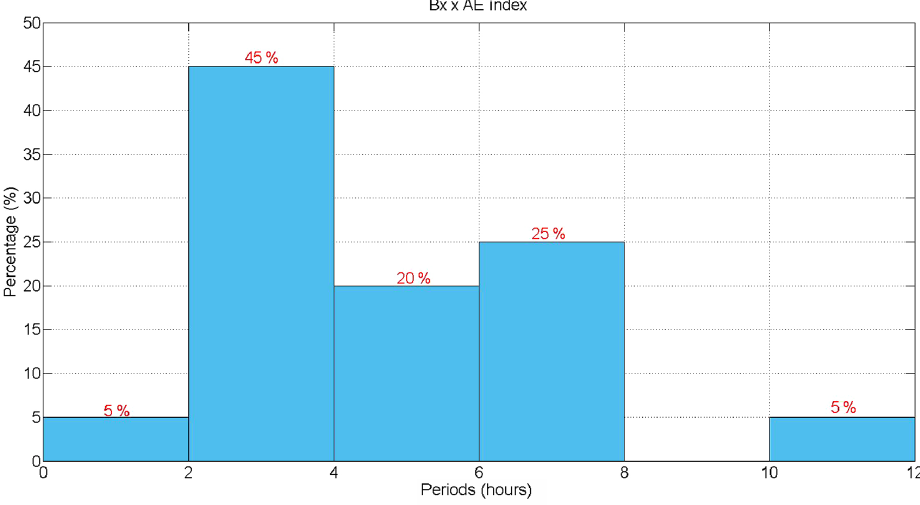
Figure 9. Histogram with the periods of high correlation between B x tail component and the AE